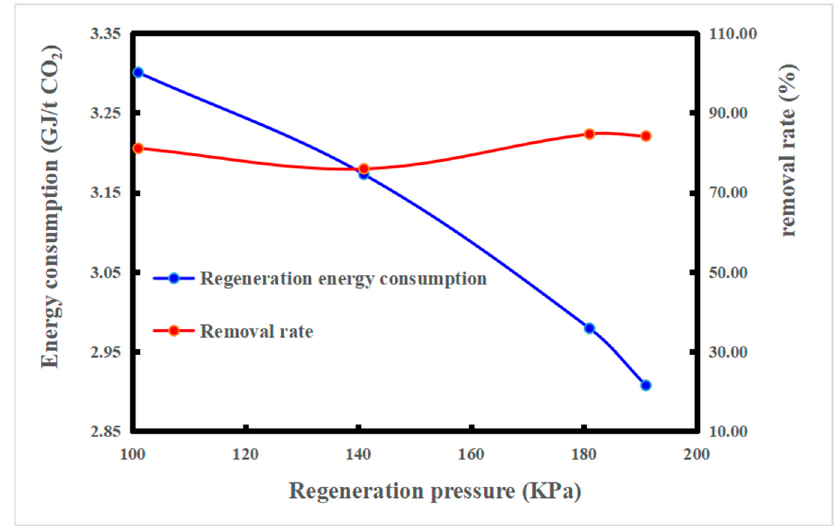
Figure 7. Effect of the regeneration pressure on the regeneration energy consumption and removal